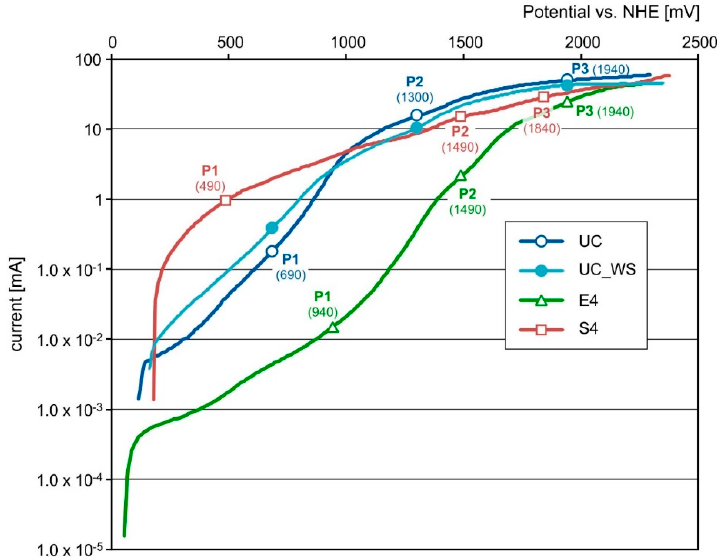
Figure 3. Current-potential curve for all materials.